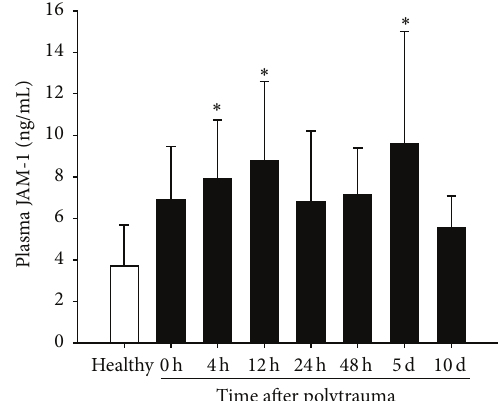
Figure 3: JAM-1 levels in plasma of polytrauma patients at the indicated time points after trauma. Data are presented as means ± SD with 𝑛 = 6–10 per group; one-way ANOVA/Dunnett’s test; ∗ 𝑃 ≤ 0.05 versus healthy